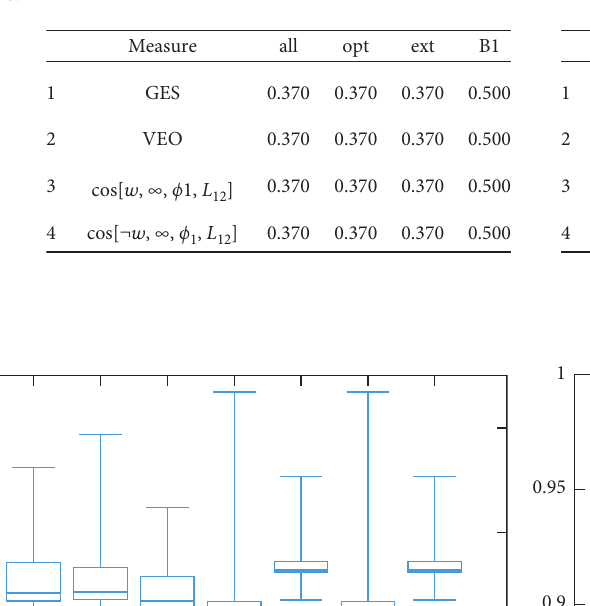
Table 8: Left: F -scores obtained for different measures and optimizations by classifying ATNs vs. TTNs according to Scenario 1 of Table 16—two target classes are considered. B1 considers Scenario 6 of Figure 16. Right: F -scores obtained for different measures and opti- mizations by classifying simultaneously for mode and genre according to Scenario 5—twelve target classes are considered. B1 considers Scenario